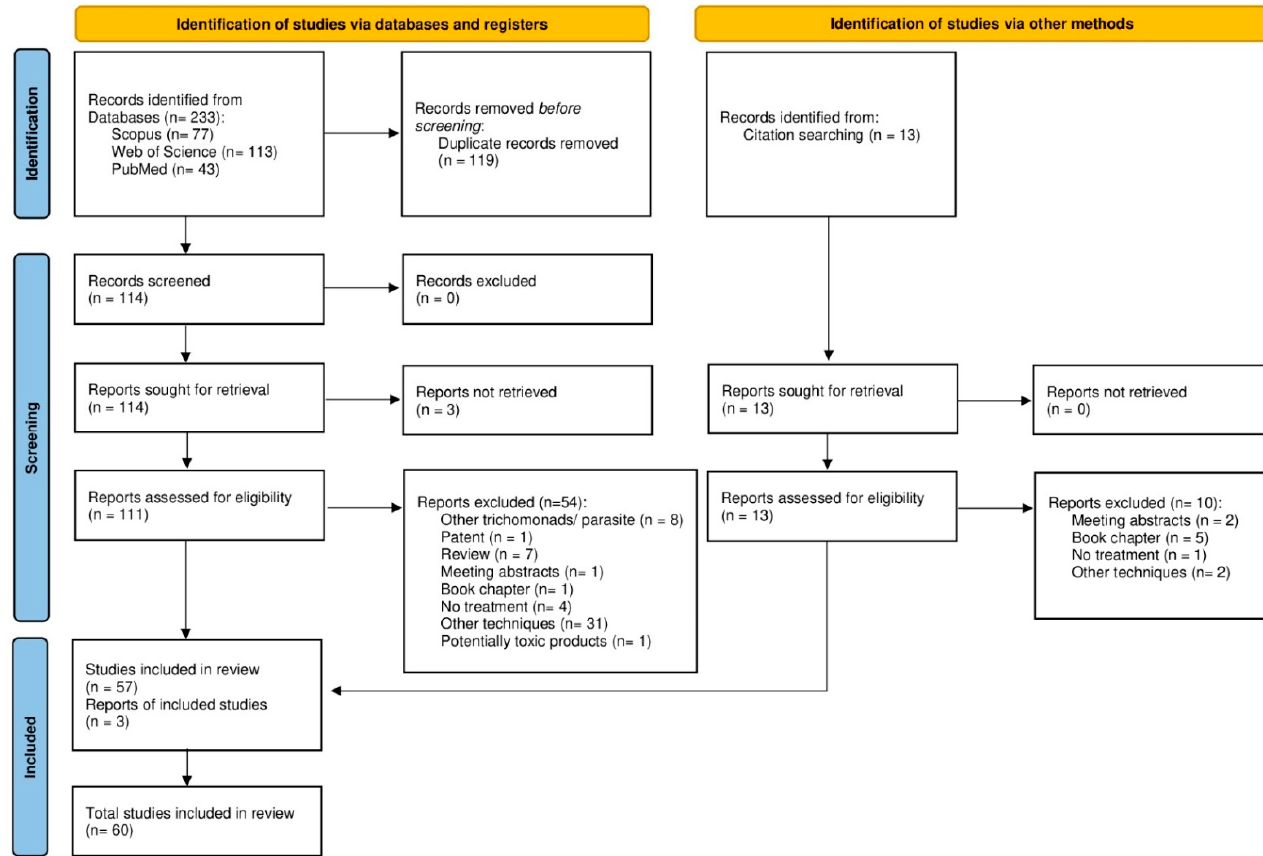
Figure 1. PRISMA flowchart employed for the systematic review of avian oropharyngeal trichomonosis treatments, failures and alternatives. The search of records was performed in PubMed, Scopus and Web of Science employing the terms and criteria conditions previously described.